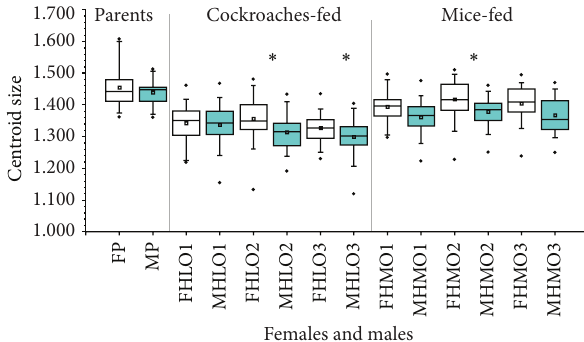
Figure 2: Sexual dimorphism in centroid size. FP ( C parent), MP ( D parent), FHLO1 ( C O1, hemolymphagy), MHLO1 ( D O1, hemolymphagy), FHMO1 ( C O1, hematophagy), MHMO1 ( D O1, hematophagy), FHLO2 ( C O2, hemolymphagy), MHLO2 ( D O2, hemolymphagy), FHMO2 ( C O2, hematophagy), MHMO2 ( D O2, hematophagy), FHLO3 ( C O3, hemolymphagy), MHLO3 ( D O3, hemolymphagy), FHMO3 ( C O3, hematophagy), MHMO3 ( D O3, hematophagy), O1 (first offspring), O2 (second offspring), and O3 (third offspring). White box (female) and blue box (male). ∗ Statistically significant